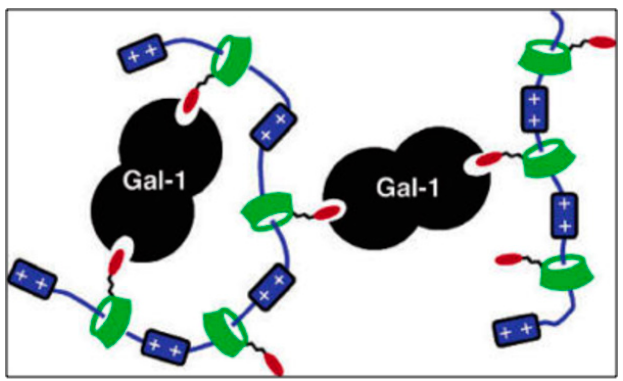
Figure 9. Self-Assembled Pseudopolyrotaxanes, statistical binding mechanism for Galectin-1. Reprinted with permission from [136]. Red is the carbohydrate, blue is a bipyridinium segment, and green is the